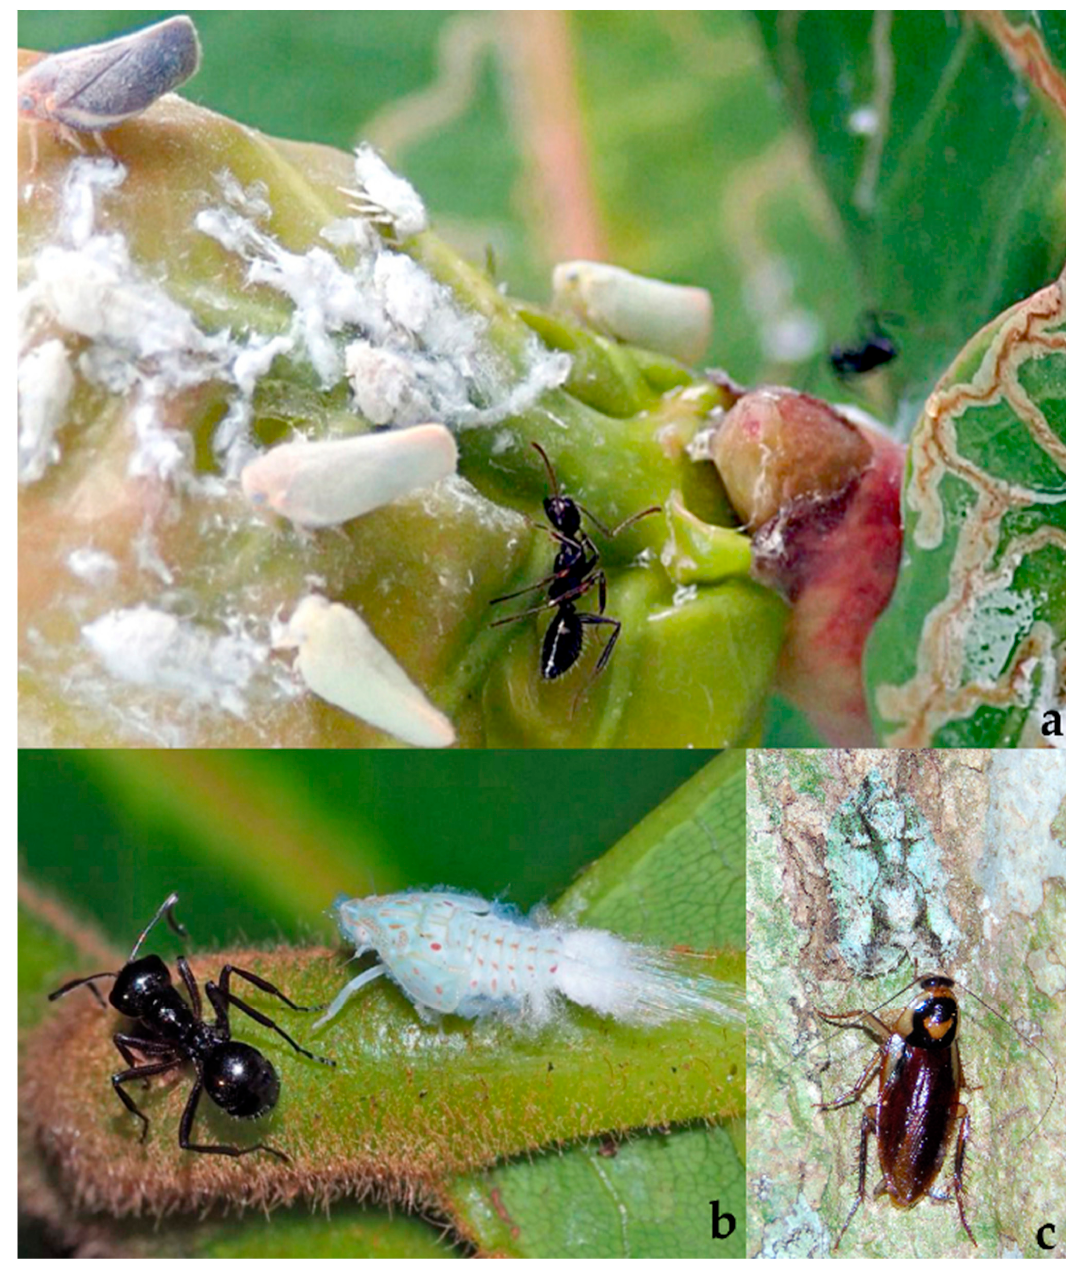
Figure 7. Flatidae: ( a ) Petrusa epilepsis (Kirkaldy, 1767) tended by Formicidae indet. Puerto Rico: San Juan, Paseo del Morro, 18 ◦ 28 (cid:48) 12.6 (cid:48)(cid:48) N 66 ◦ 07 (cid:48) 28.5 (cid:48)(cid:48) W, 11.12.2018, nymphs and adults, obs. C. O’Neill; ( b ) Siphanta sp. tended by Formicidae indet., Australia: Queensland, Cairns, 16 ◦ 49 (cid:48) 10.7 (cid:48)(cid:48) S 145 ◦ 37 (cid:48) 59.4 (cid:48)(cid:48) E, nymph, obs. C. Page; ( c ) Flatoidinae sp. tended by Blattodea indet., Vietnam: Kon Chu Rang National Park, 14 ◦ 28 (cid:48) 28 (cid:48)(cid:48) N 108 ◦ 32 (cid:48) 27 (cid:48)(cid:48) E, 19.07.2018, adult on tree trunk, obs. J.